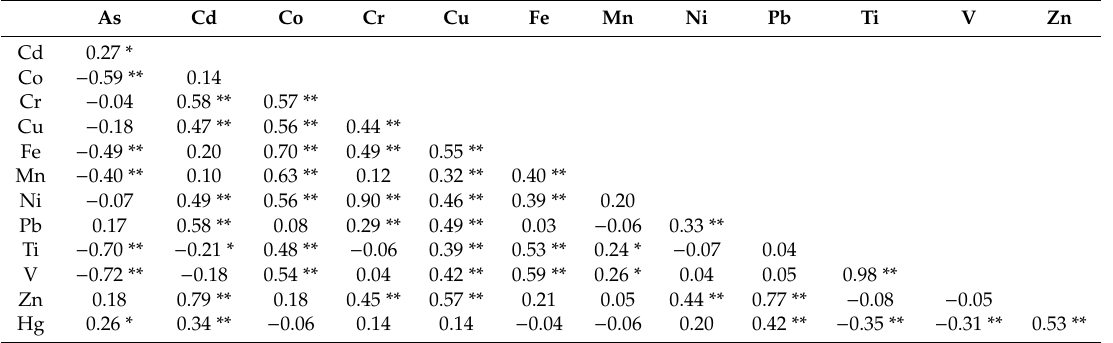
Table 5. Spearman’s correlation coe ffi cient matrix between pseudo-total metal concentrations in the soils studied.